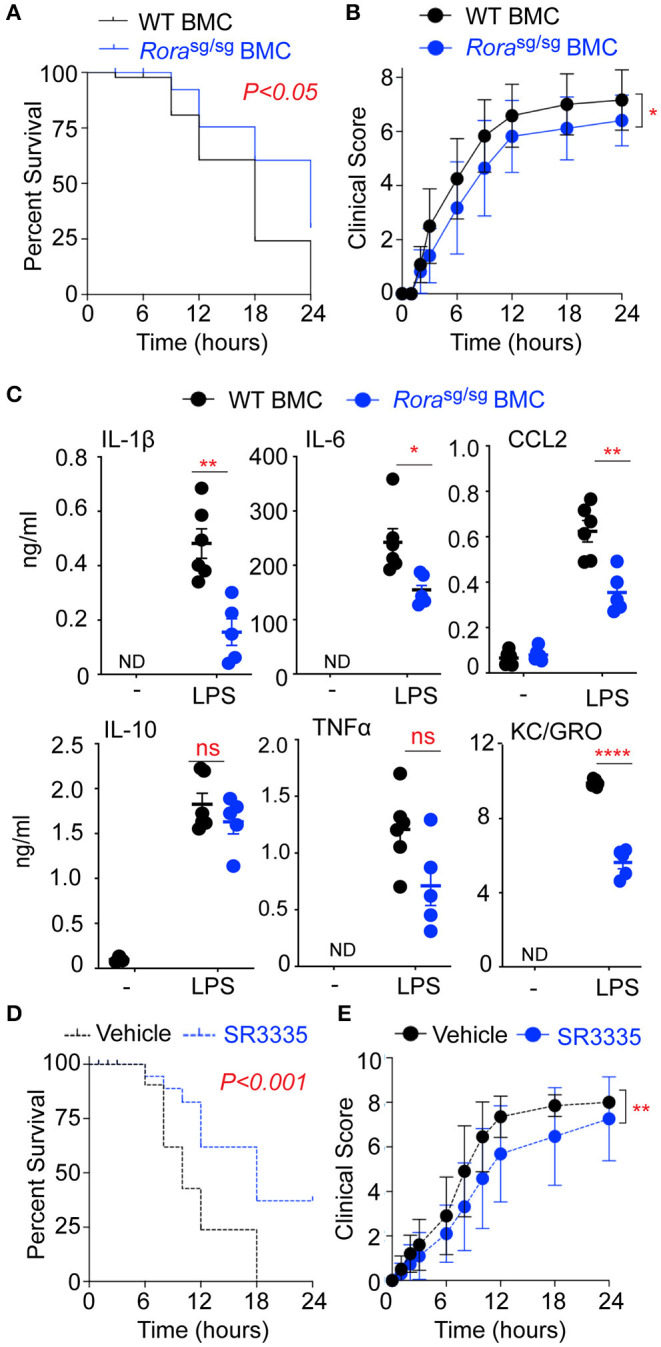
RORα BMC mice have decreased disease severity and inflammatory cytokine release in response to LPS. BMC mice were generated via transfer of bone marrow isolated from WT and Rorasg/sg mice into irradiated WT recipients (n = 12 and n = 17, respectively). Mice were challenged with 10 mg/kg UP-LPS i.p. and were monitored periodically for 24 h post LPS injection and death (A) and clinical score (B) recorded. Blood was collected from naïve BMC animals (-) and treated mice 3 h post LPS injection (LPS; n = 6 per group), serum cytokines and chemokines were determined by ELISA (C). WT mice were treated with vehicle control (n = 20) or SR3335 (n = 19) at a dose of 15 mg/kg for days i.p. On day 8 mice were challenged with 10 mg/kg ultra-pure LPS i.p. and were monitored periodically for 48 h post LPS injection and death (D) and clinical score (E) recorded. *P < 0.05, **P < 0.01, ****P < 0.00001.